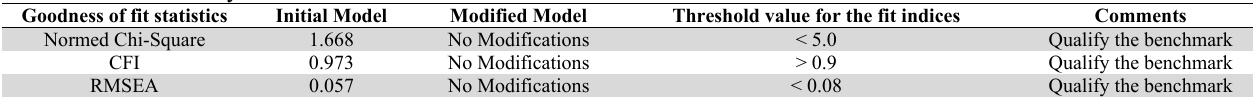
Model fit in SEM analysis Goodness of fit statistics